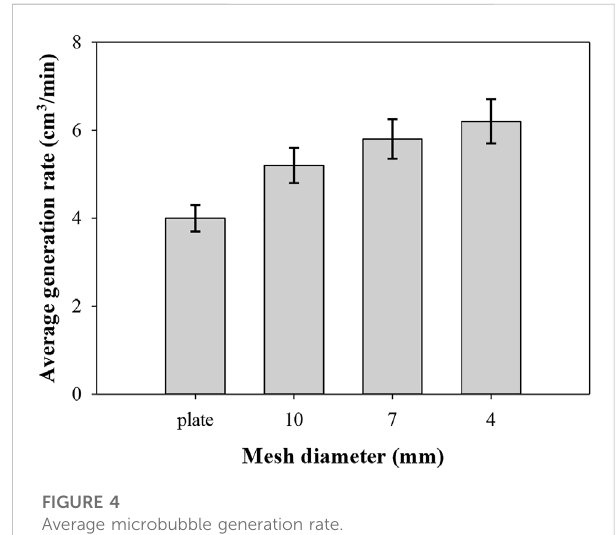
FIGURE 4 Average microbubble generation rate.